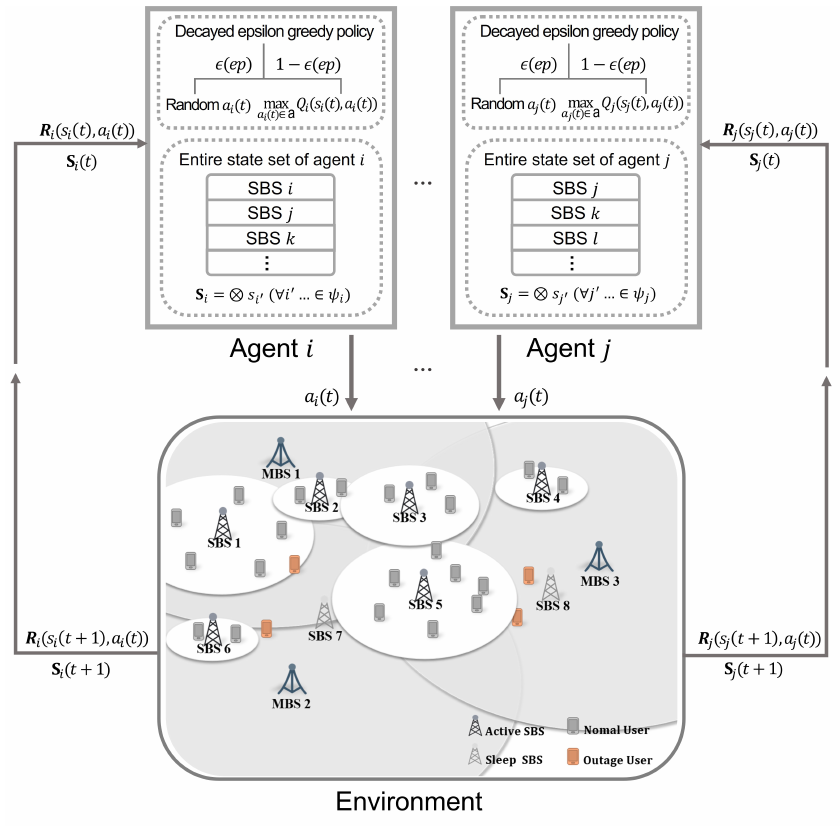
Figure 1. System model of proposed multi-agent Q-learning framework for maximizing EE while minimizing user outage in ultra-dense small cell